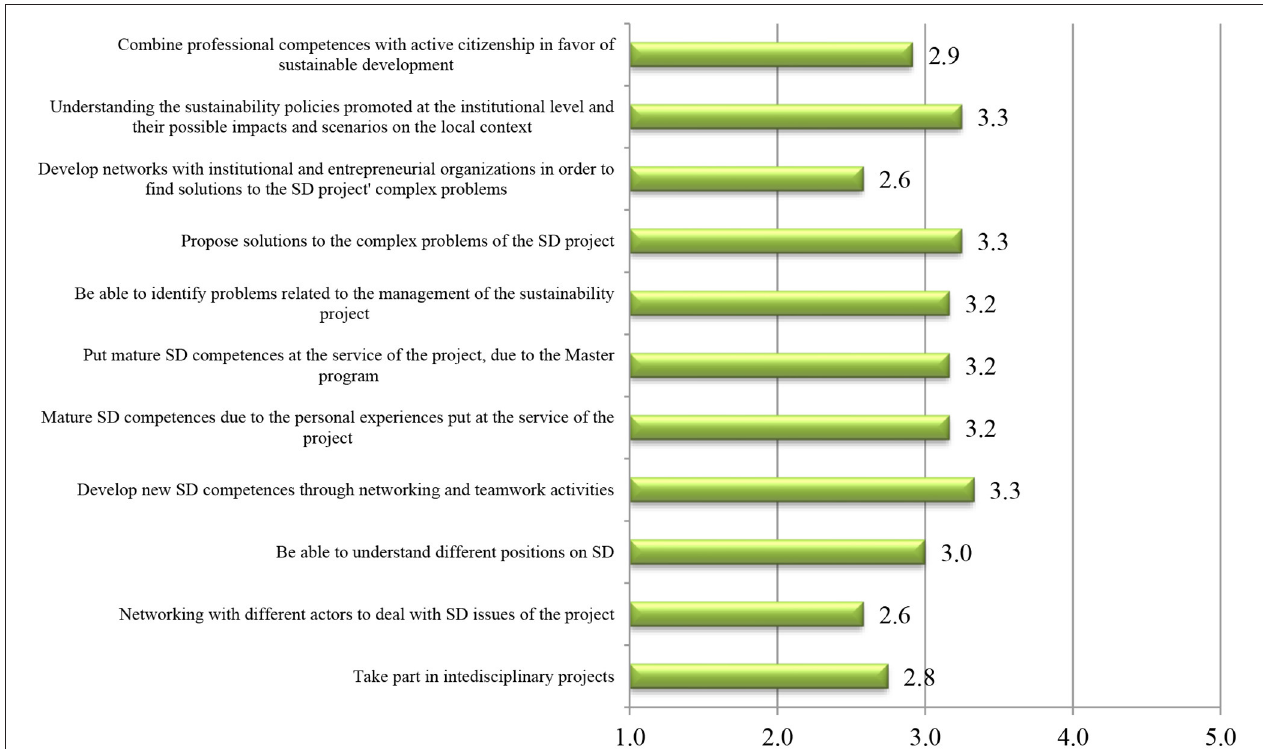
FIGURE 3 | SD competences developed through and applied in internships and project